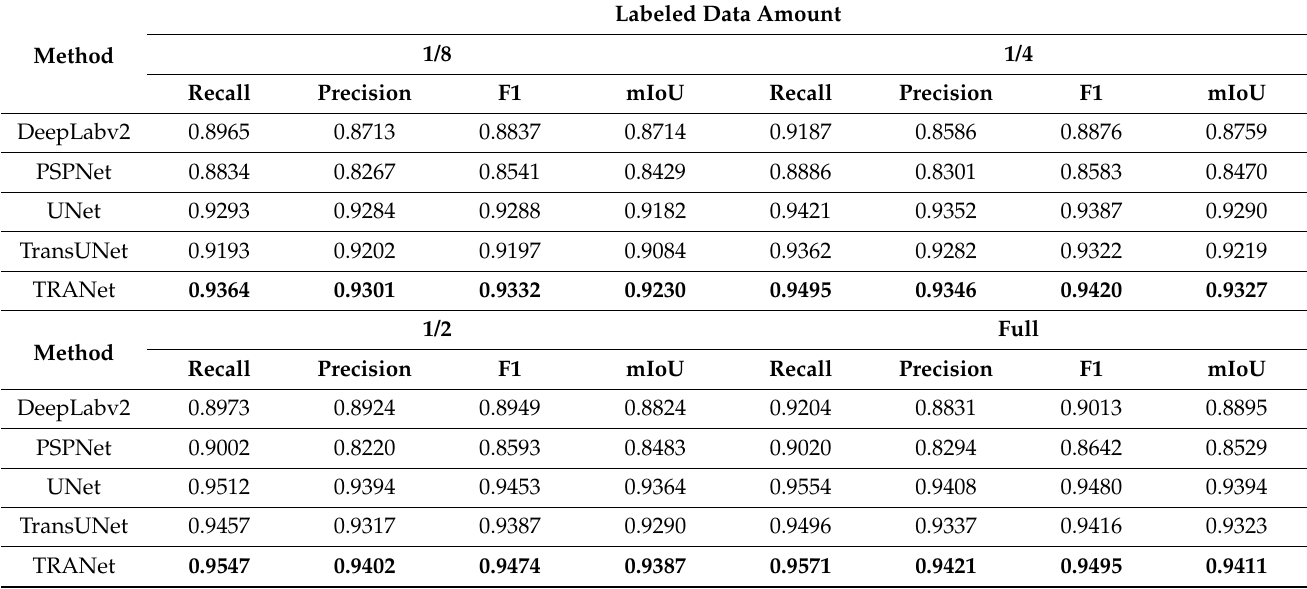
Table 2. Building extraction accuracies obtained with different quantities of labeled data on the WBD. The highest accuracy is displayed in